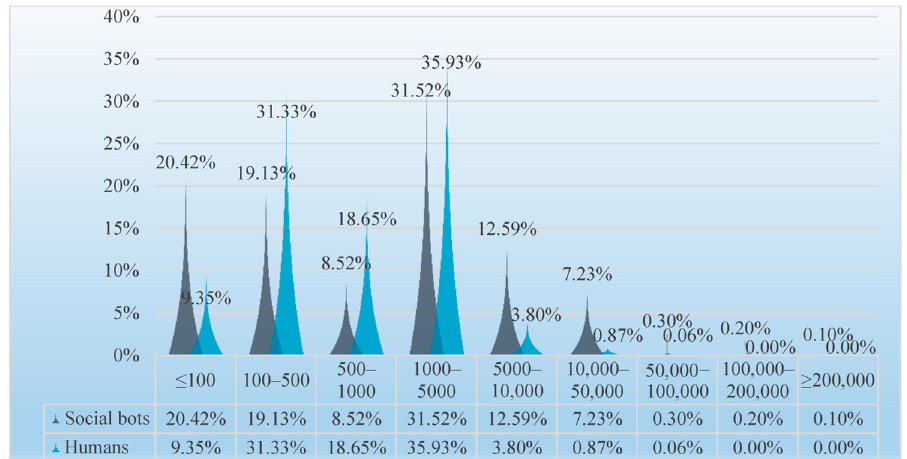
Figure 12. Distribution of the number of friends of social bots and humans. (4) Tweeting